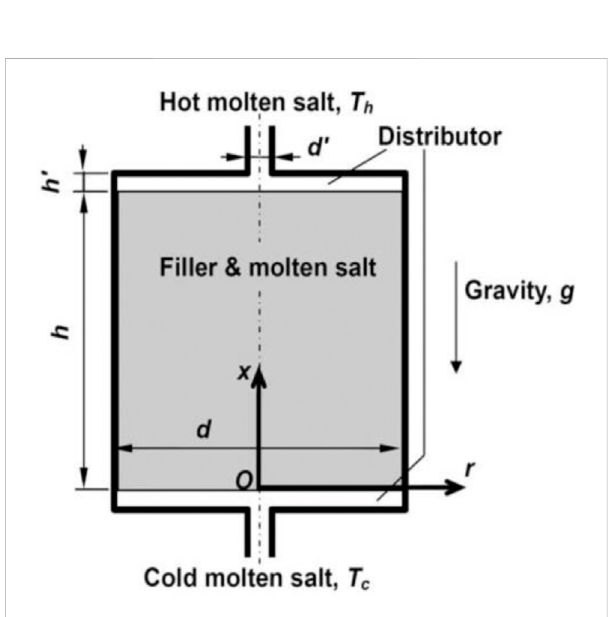
FIGURE 10 Diagrammatic representation of the thermocline TES system (Yang and Garimella, 2010). License Number: 5526341331974.